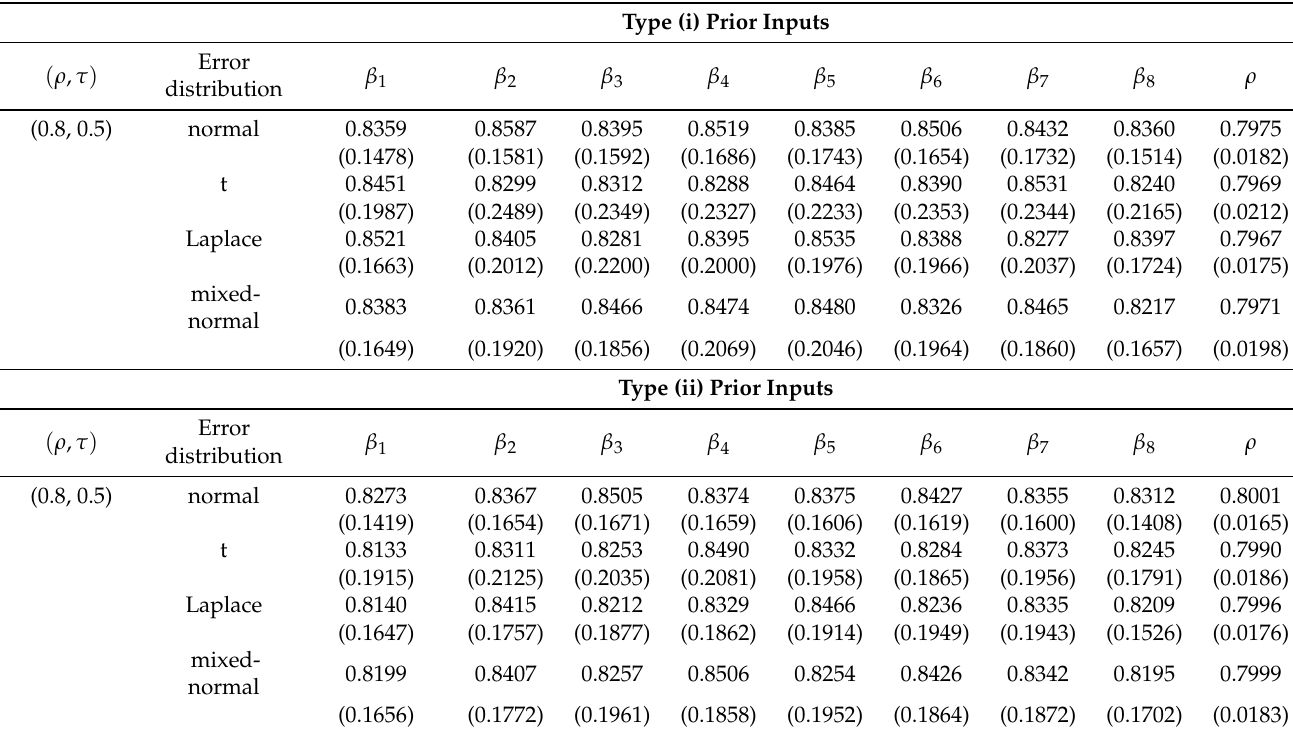
Table A2. Means and RMSs (in parentheses) in the simulation study in Appendix